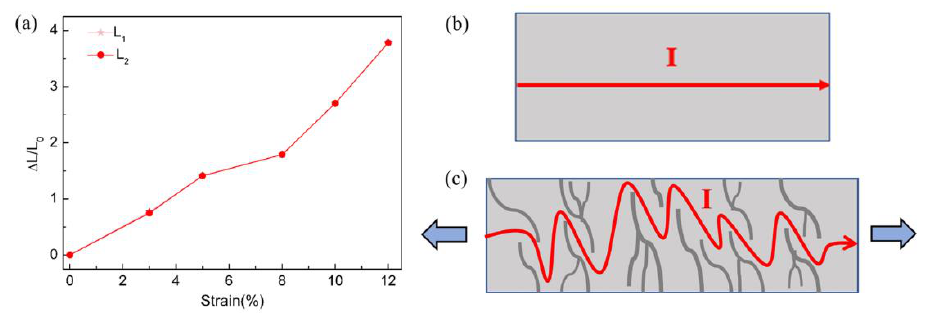
Figure 9. ( a ) The change of the inductance under strain. ( b ) The current path with 0% strain ( c ). The current path blocked by the microcracks.